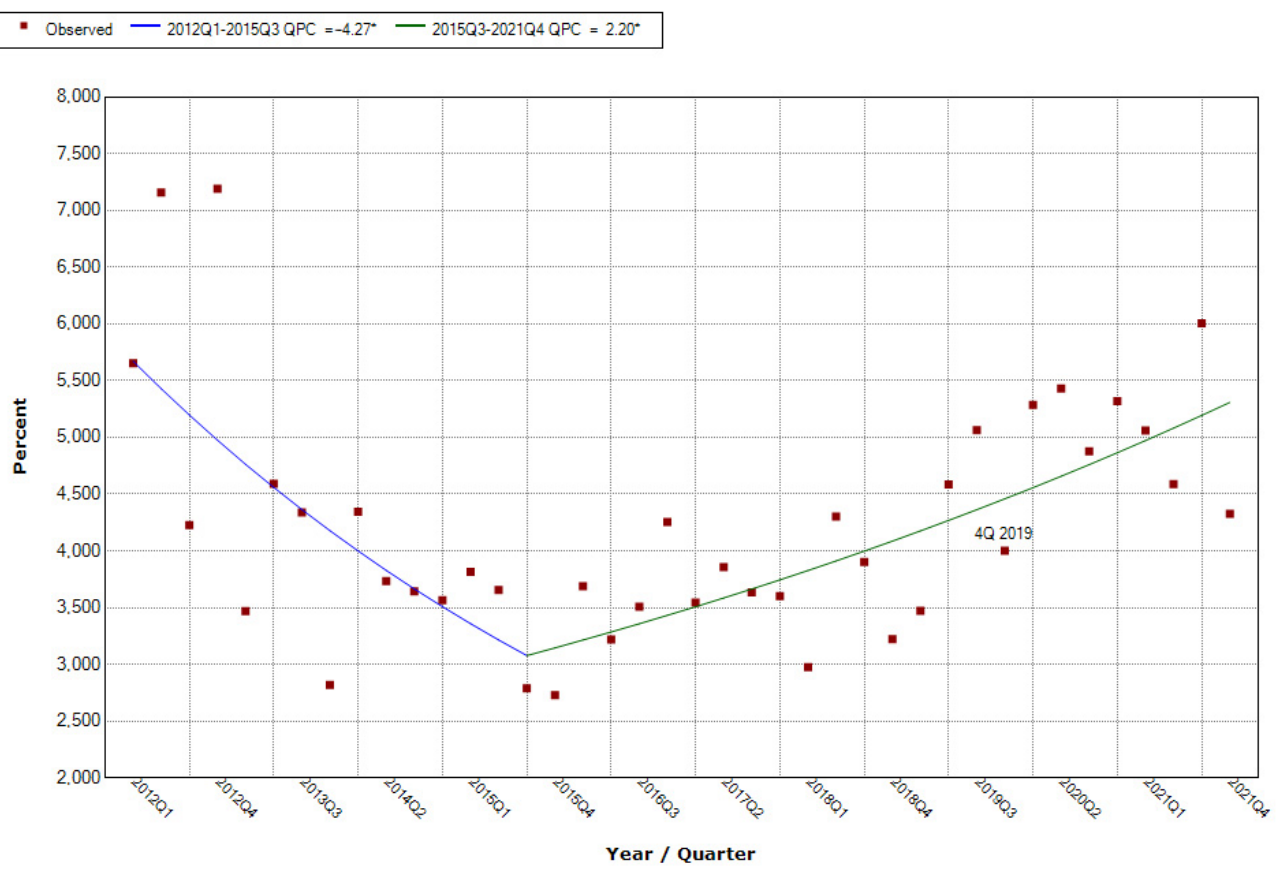
Figure A19. Percentage of products containing iodine in individual quarters in the period from 2012 to 28 November 2021. Joinpoints mark trend turning points. The date above the observation indicates the moment of publication of the scientific opinion/resolution.